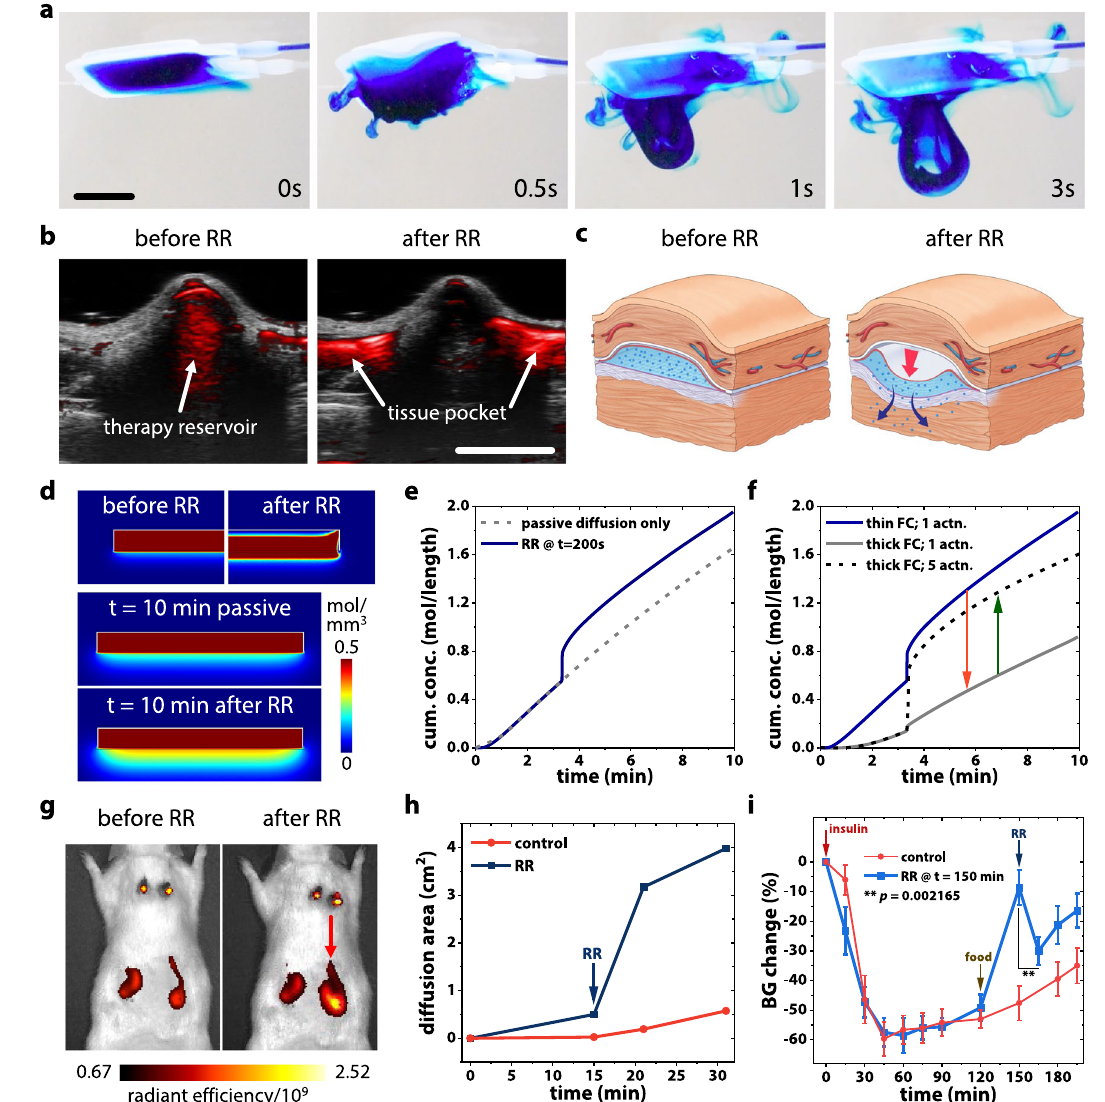
Fig. 5| On demand,actuation-mediatedrapidrelease(RR)ofdrug using STAR. a RR enables convective fl ow of a model drug, methylene blue, from the therapy reservoir of STAR. Scale bar is 5mm. b Photoacoustic images showing sub- cutaneously implanted STAR in a rat model: RR enables convective fl ow of drug analogue (red) from the therapy reservoir into the surrounding tissue pocket. c Schematic showing actuation-mediated RR overcoming fi brous encapsulation. d Snapshots from COMSOL Multiphysics simulation showing the rate-limiting dif- fusion barrier created by a FC and the ability to improve transport using RR. e Concentrationofdrug outside the FCcomparing passive diffusion alone to RR at 200s. f ConcentrationofdrugoutsidetheFCforathin(100 μ m)orthick(200 μ m)